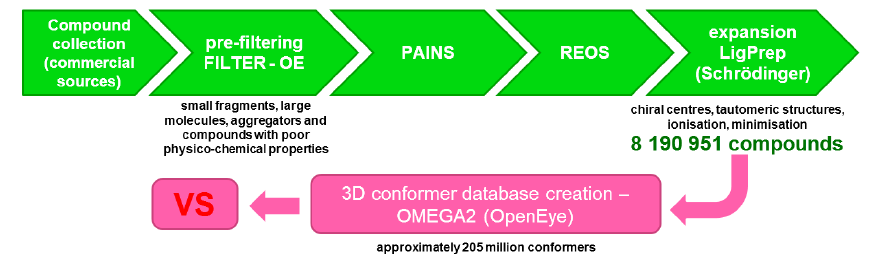
Figure 2. Database preparation for subsequent virtual screening (VS) on the SARS-CoV-2 main protease 3CL pro or M pro . The final database contained 8,190,951 molecules before conformer generation.